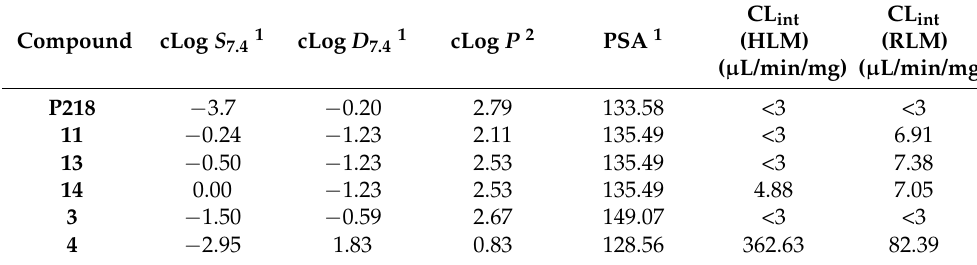
Table 3. In silico and in vitro ADME properties of selected compounds.